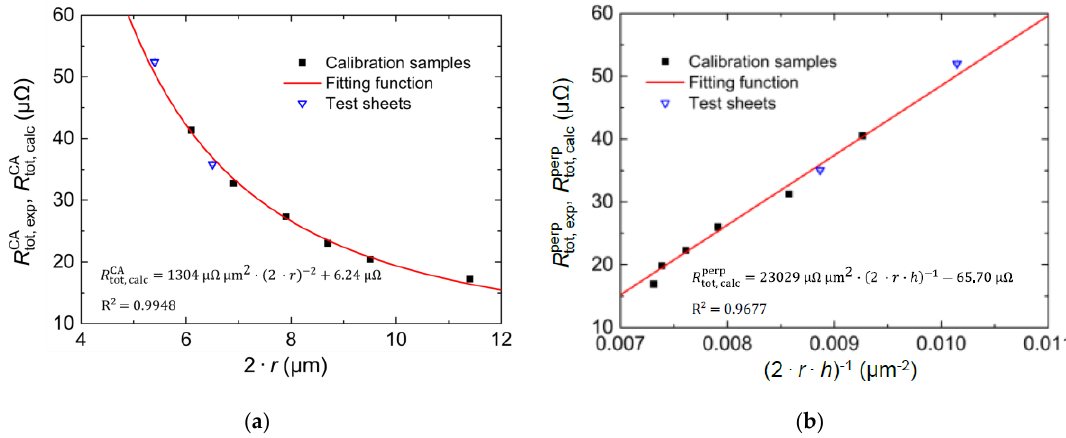
Figure 5. Electrical resistance of DC04 sheets ( a ) along the rolling direction in dependence of the grain diameter and ( b ) perpendicular to the rolling direction in dependence of the reciprocal grain area.